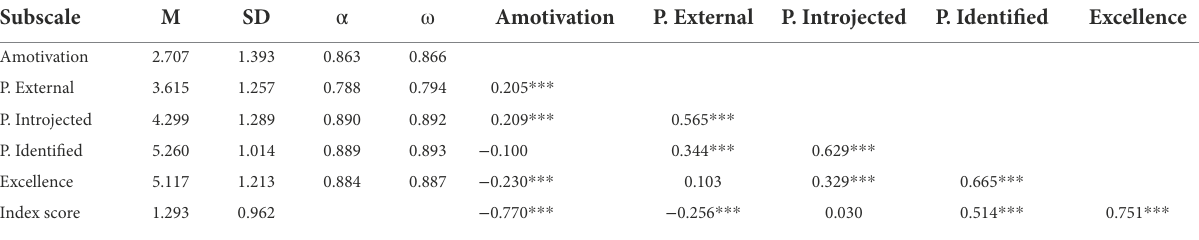
TABLE 2 Reliabilities, means, standard deviations, and intercorrelations of each subscale, Study 1a.